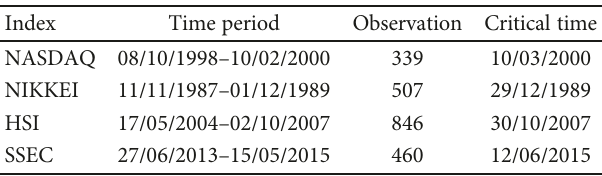
Table 2: Data description. “ Time period ” is the maximum time span used in our estimation, and “ Observation ” is the total number of data points in the sample. “ Critical time ” is the date which corresponds to the peak of bubbles.